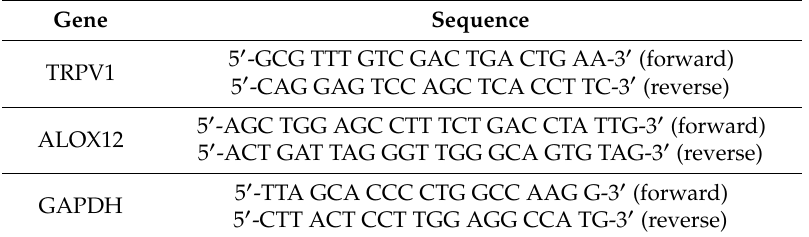
Table 1. PCR primer sequences in RT-qPCR for the measurement of mRNA expression in